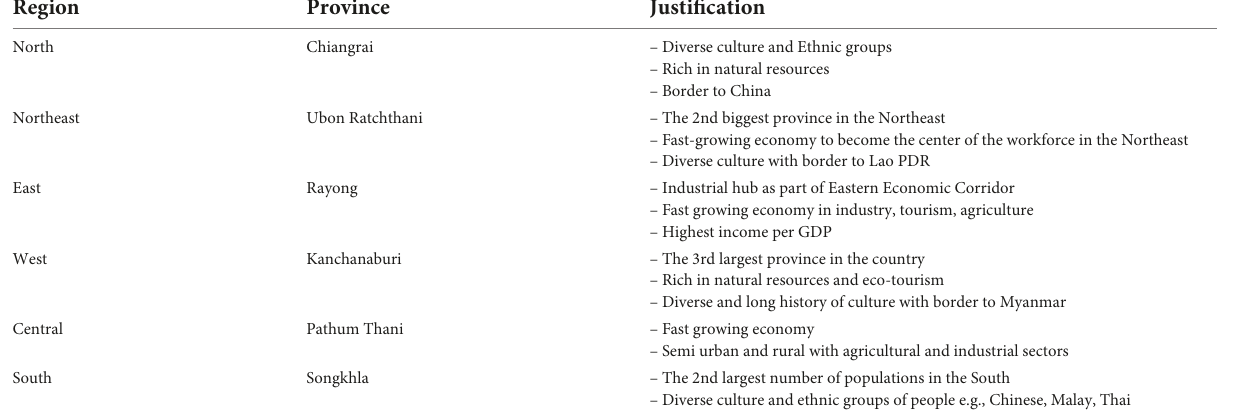
TABLE 1 Sampling procedure for